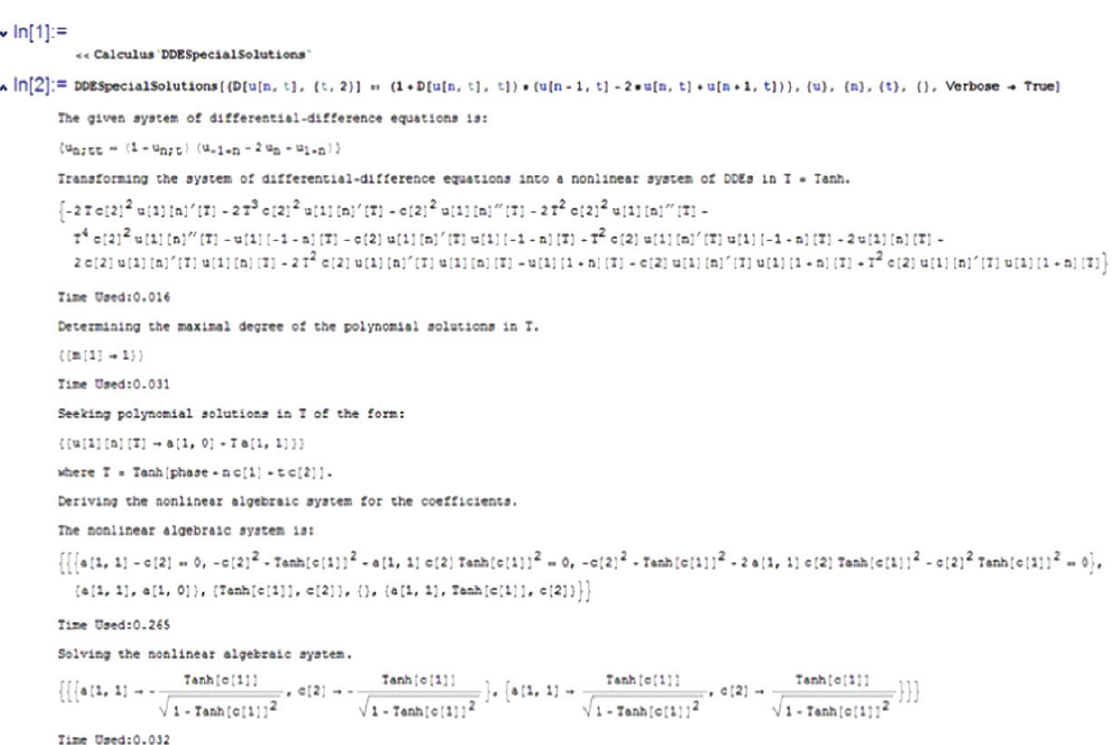
Figure 13 . Applying the chain rule